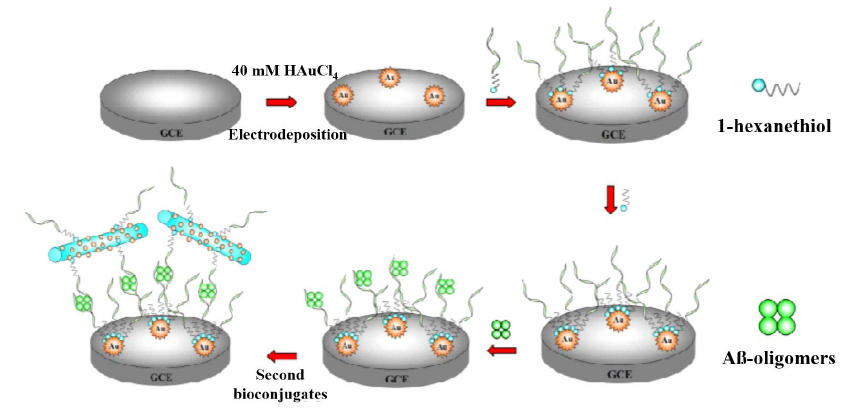
Figure 3. Schematic illustration of the fabrication of the aptasensor for A β Os detection. Reprinted with permission from Ref. [116].